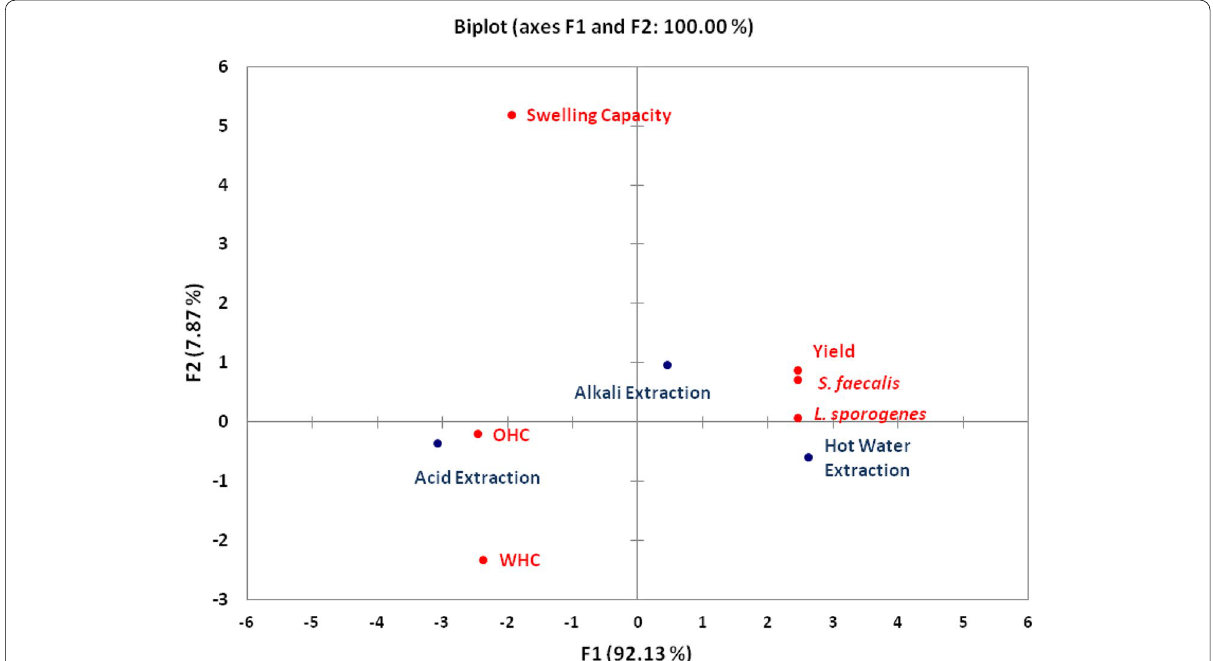
Fig. 4 PCA biplot of effect of different extraction techniques towards the different physiochemical and prebiotic properties of apple